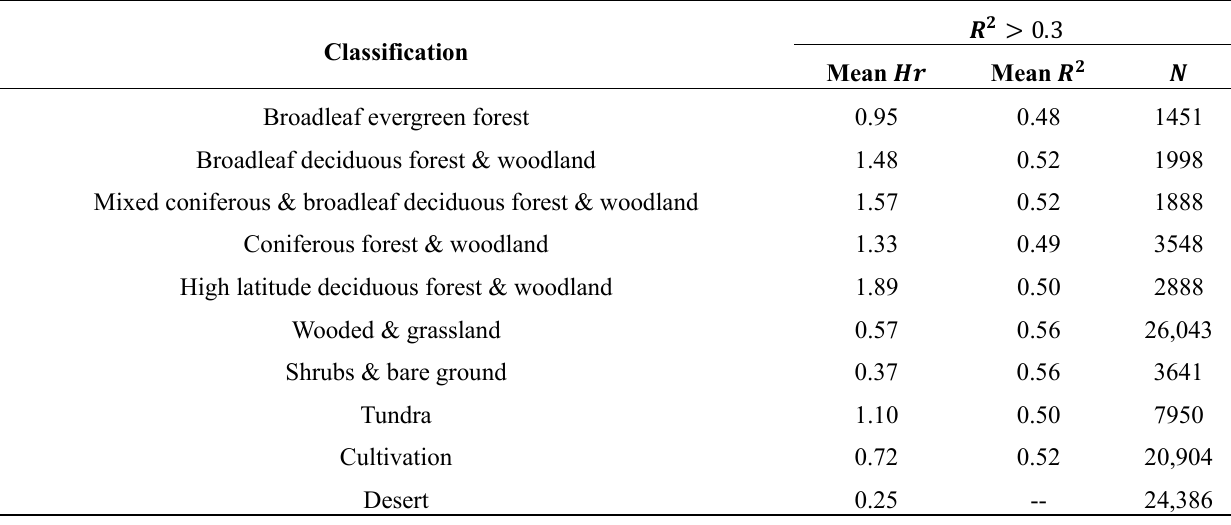
Table 6. Table 2 using a R 2 threshold of 0.3, instead of 0.2.